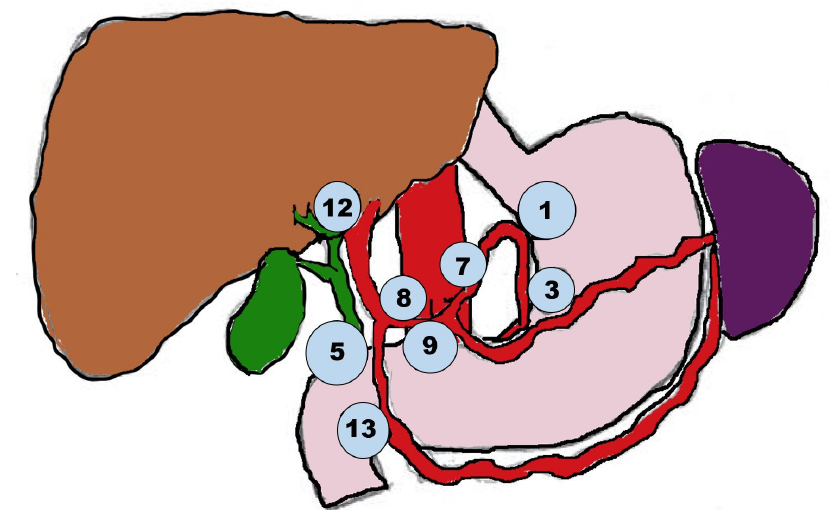
Figure 1. Lymph node locations for ICC lymphadenectomy.